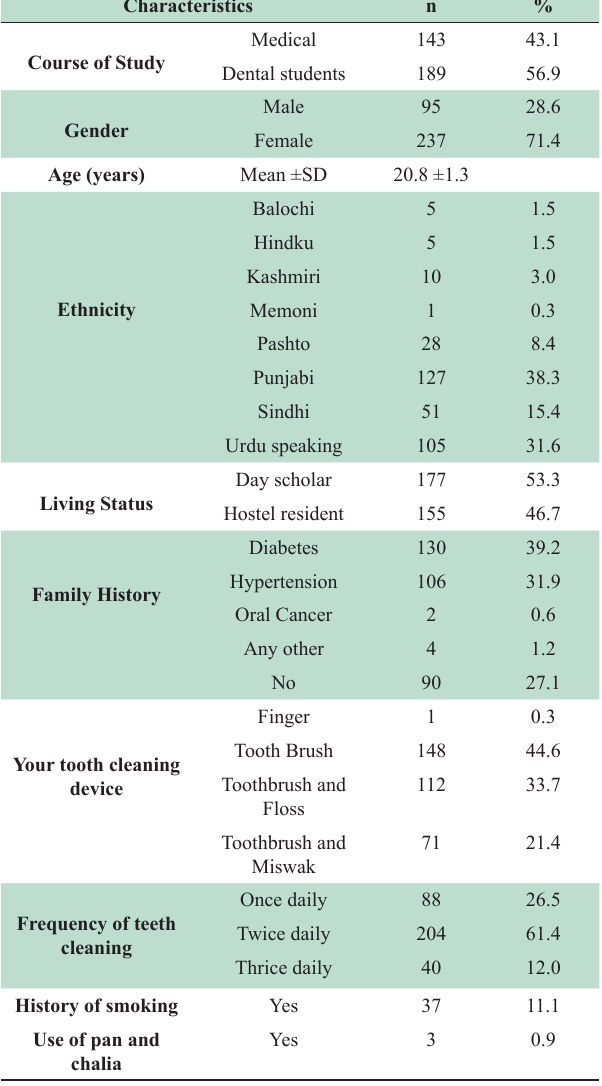
Table-I: Baseline Characteristics of Studied Samples